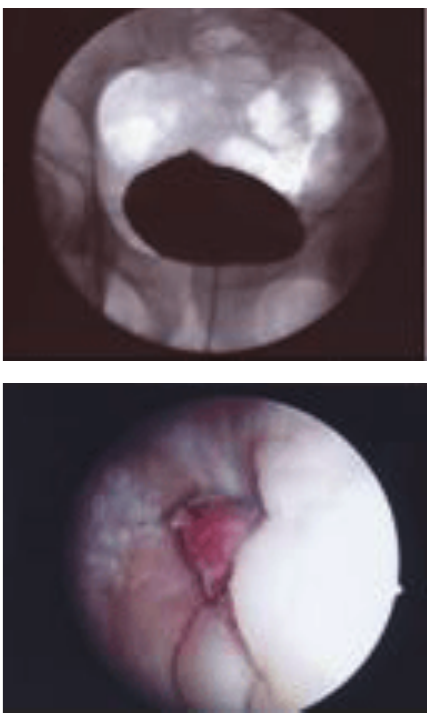
Figure 2: Tc scan and 3D reconstruction of pelvis. Toothpick is visible in both